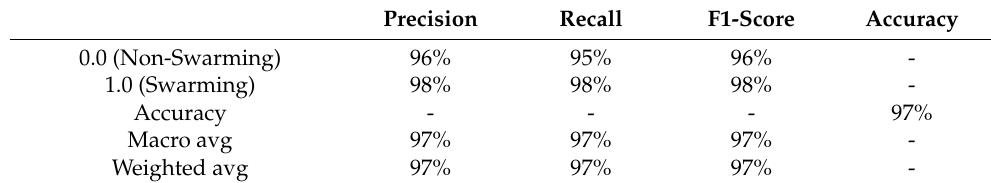
Table 5. SVM Classifier results applied five days before the swarming event. Precision Recall F1-Score Accuracy